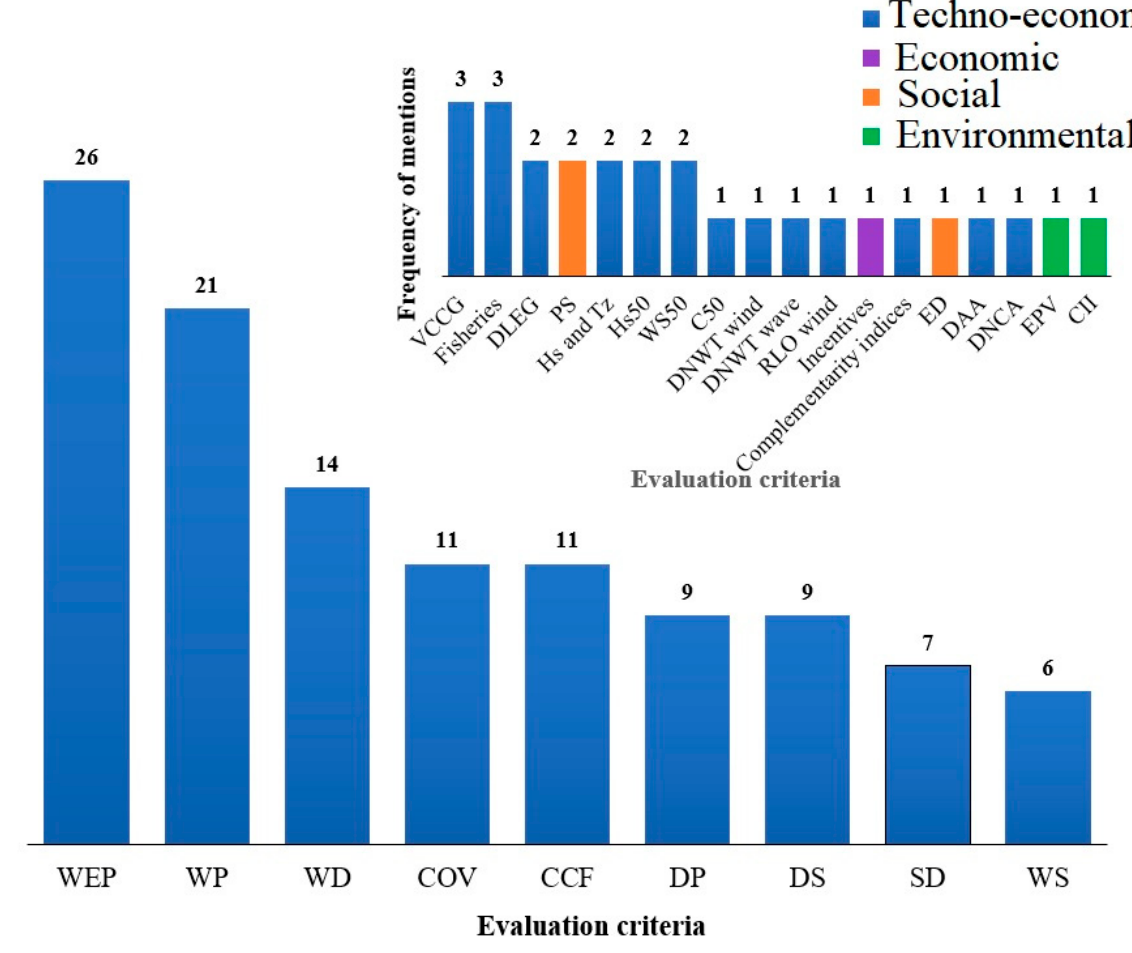
Figure 4. Frequency of occurrence of EV criteria in the literature.